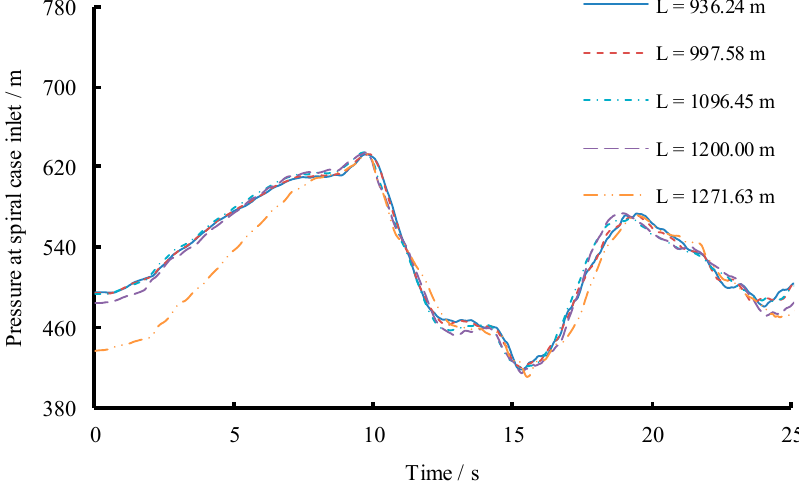
Figure 17. Maximum SCP with different time intervals for each scheme of Scenario 3.